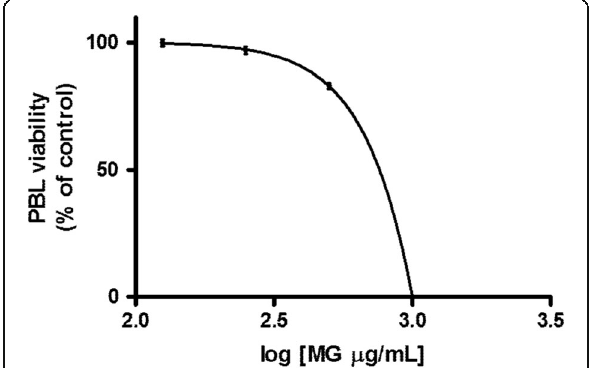
Fig. 9 Effect of MG on viability of PBL. IC 50 was obtained by curve fitting of viable cells after 24 h treatment. Data are presented as mean ± SEM of five independent